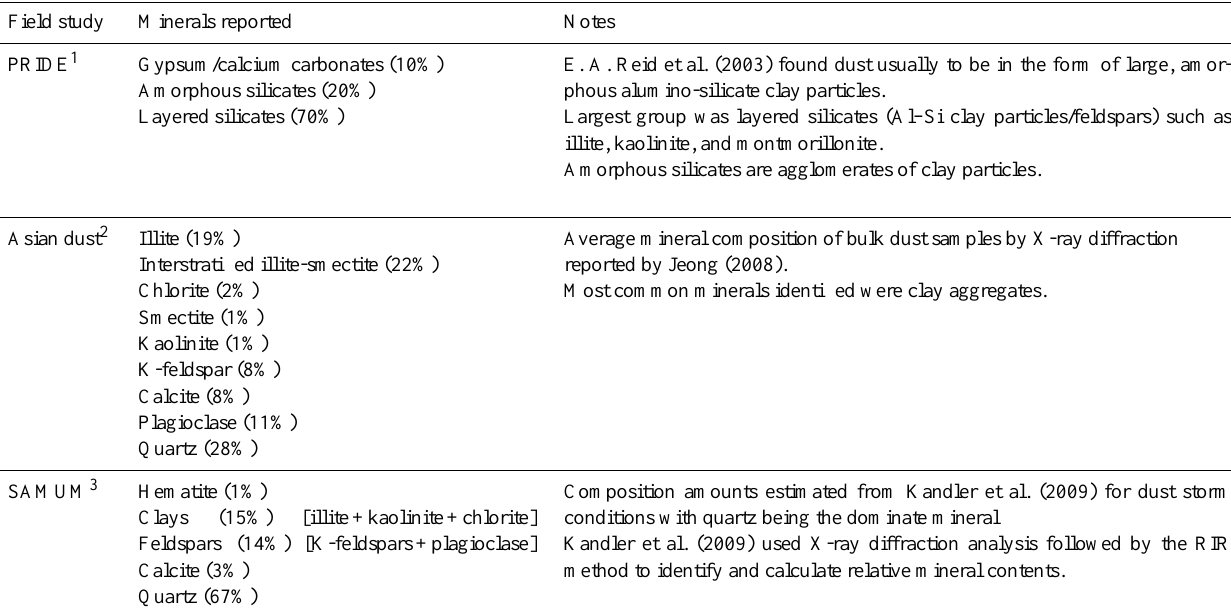
Table 2. Minerals identified during past field